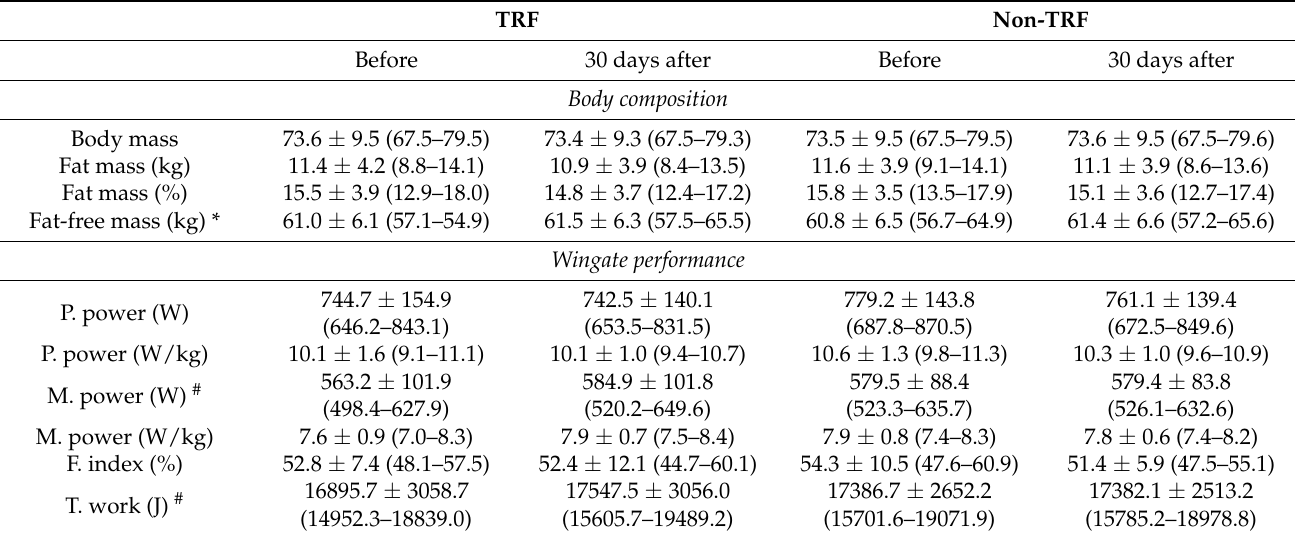
Table 3. Body composition and Wingate performance after 30 days of time-restricted feeding (TRF) and non-time-restricted feeding (non-TRF).